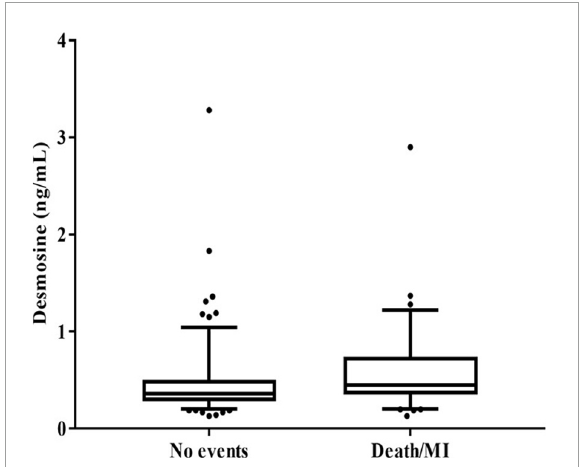
FIGURE1 Box plot showing plasma desmosine (pDES) concentrations according to no events vs. death/myocardial infarction (MI) at 2 years ( p = 0.002 by Mann–Whitney U